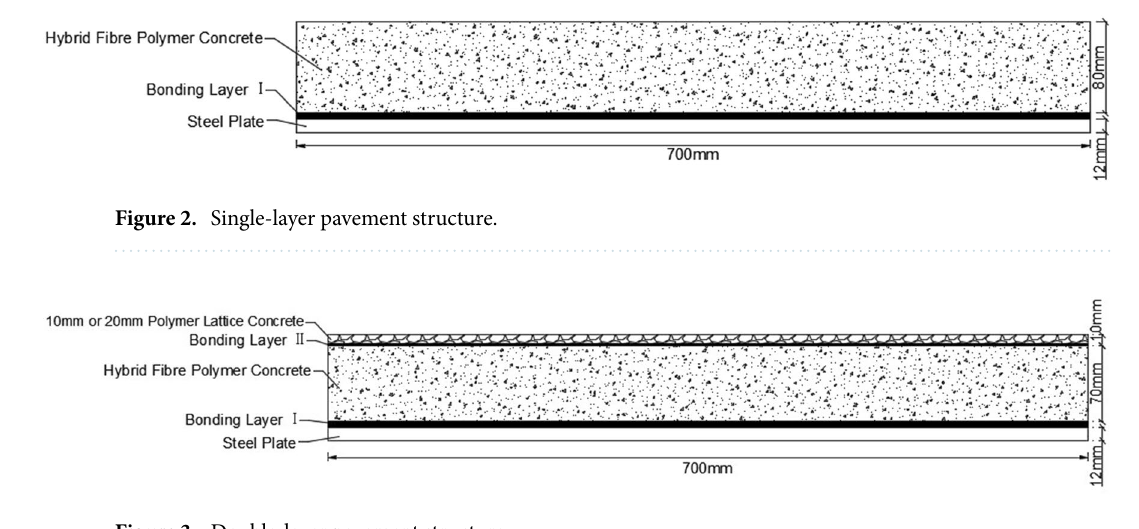
Figure 3. Double-layer pavement